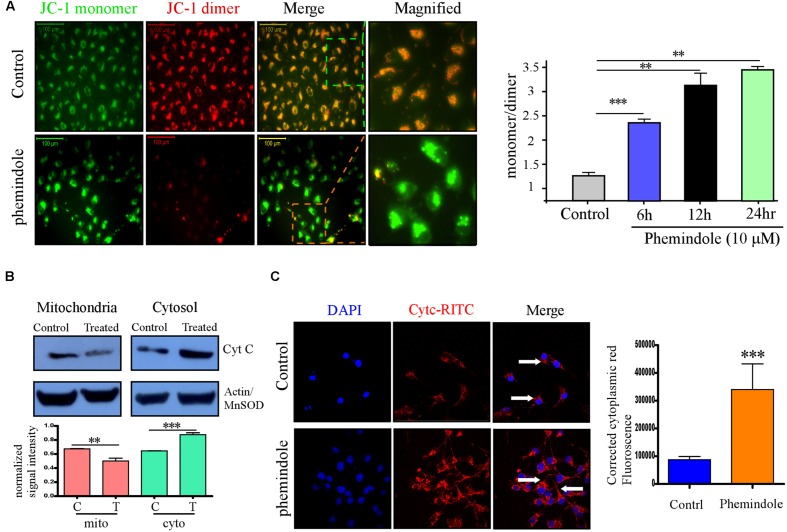
Phemindole potentiates mitochondrial membrane potential depolarization and Cytochrome C release in MDAMB-231 cells.
(A) Fluorescence microscopic images of the MDAMB-231 cells stained with JC-1 dye for detecting the changes in mitochondrial membrane potential in both control and Phemindole treated cells. The red fluorescence intensity in the Phemindole treated cells was weaker than in the control cells (Left panel). Bar diagram shows the quantitative monomer (Red Fluoroscence)/dimer (green fluorescence) ratio at different time point of Phemindole (10 μM) treated set (Right panel). (B) Western blot assay showing Cyt C release (upper panel). The level of Cyt C increased in the cytoplasm and decreased in the mitochondria of the MDAMB-231 cells treated with the Phemindole, indicating that Phemindole caused the release of Cyt C from mitochondria. β-actin for cytosol and Mn-SOD for mitochondria were taken as positive control. Blots are representative of three independent experiments and quantifications are indicated by Bar diagram (lower panel). Values were normalized by intensity of positive control. (C) Immunofluorescence images of Cyt C –TRITC (Red) and DAPI (blue) staining in MDAMB-231 cells from untreated and Phemindole treated sets (Left panel). Pictures showed representative cells of each population and were representative of three independent experiments. Corrected cytoplasmic red Fluorescence intensity was quantified following the protocol described in material method section (Right panel). ∗, ∗∗, ∗∗∗ indicate p < 0.05, p < 0.01, p < 0.0005 versus untreated cells.